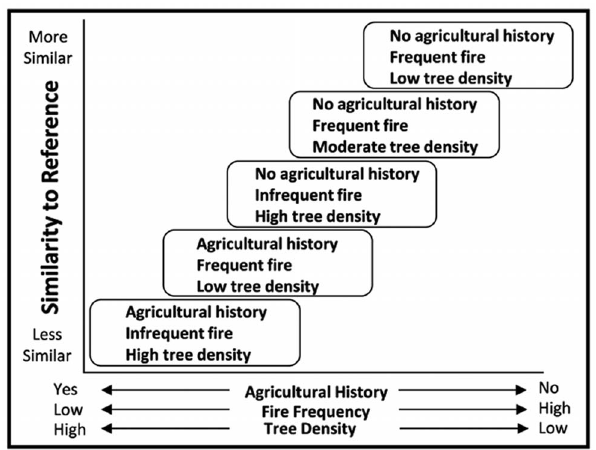
Figure 1. Conceptual model of degradation for understory plant communities in longleaf pine woodlands. Understory degradation (deviation in community composition from reference site conditions) is predicted to increase with occurrence of agricultural history, increasing overstory density, and declining fire frequency. Note: not all combinations of model components are presented in this figure and, while depicted as a linear process in this conceptual diagram, nonlinearities may exist during restoration from degraded states. Model is based on [8].